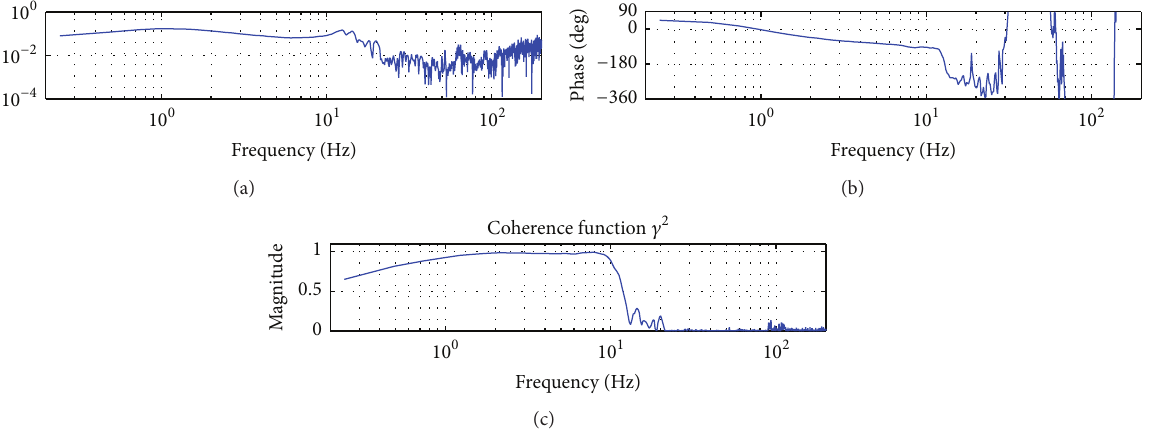
̇𝜃 𝑇 1 / 5 : modulus (a), phase (b), and coherence function (c).